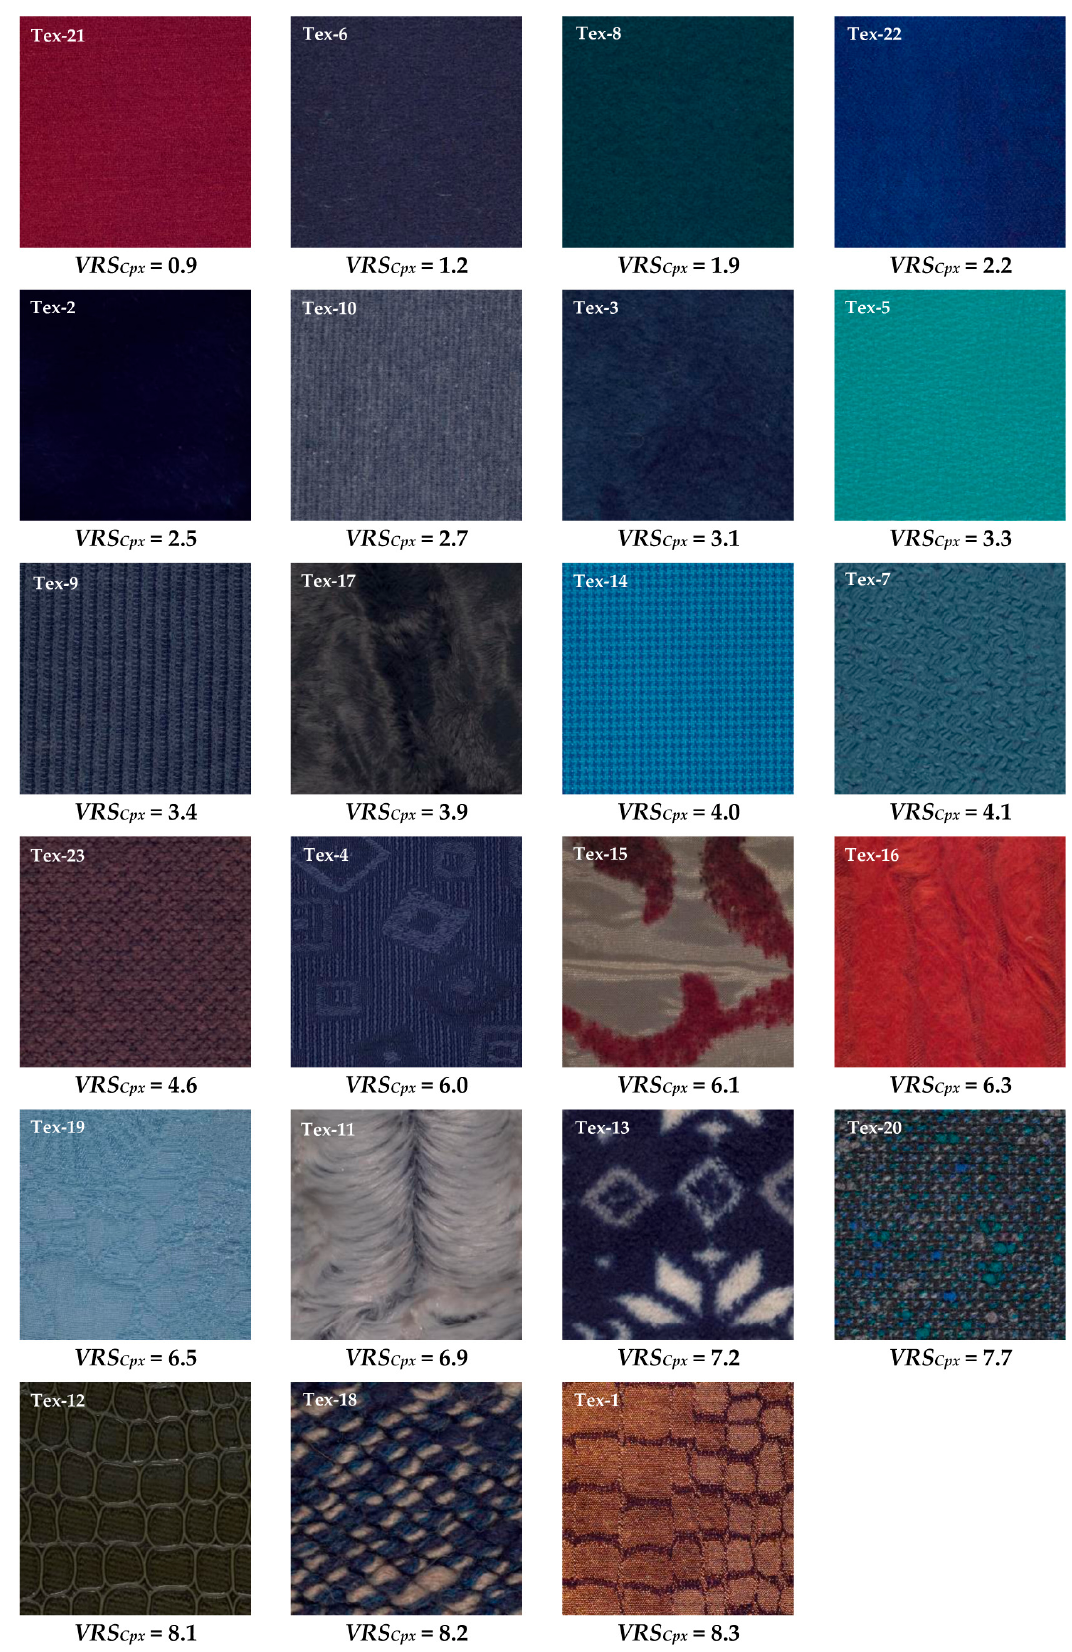
seem different from their digital counterparts, which were rendered under standard D65 illumina- tion. The sRGB renderings of the samples are introduced in Section 3.2 and Figure 5.